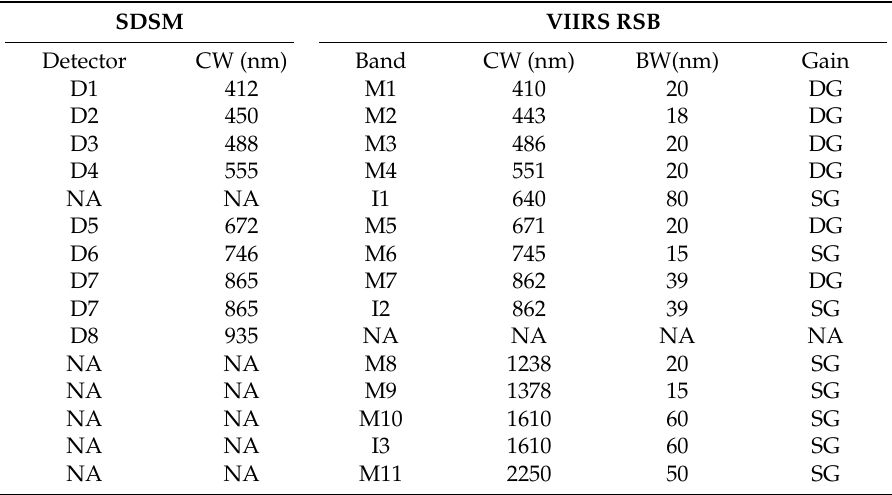
Table 1. VIIRS RSB and SDSM